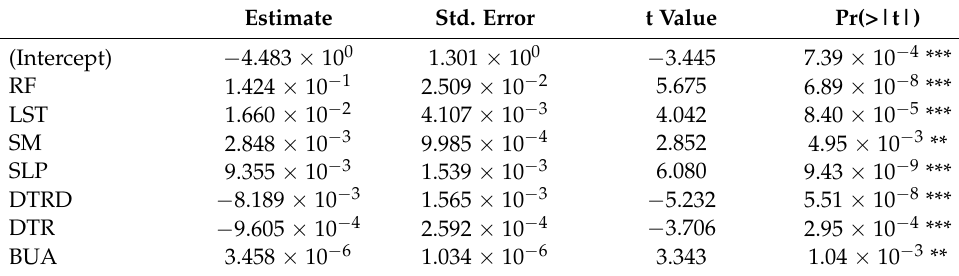
Table 5. Significance of the variables used in the MLR algorithm.